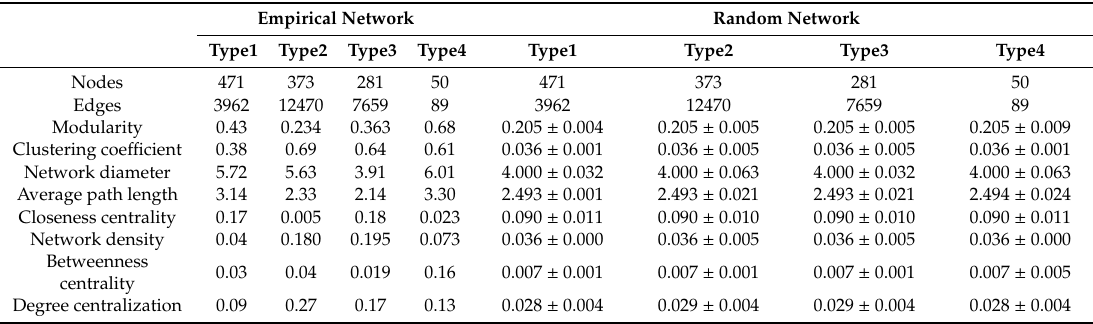
Topological properties of the co-occurrence networks of microbial communities in Bauyangdian